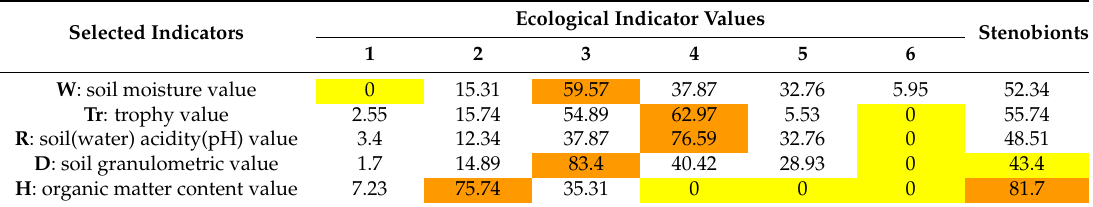
Table 6. The percentage shares of plant species with different habitat requirements in the flora (based on Zarzycki et al. 2002 [42]) of the study area in 2015 and 2018 (extreme values are marked with colours: yellow, min; orange, max).